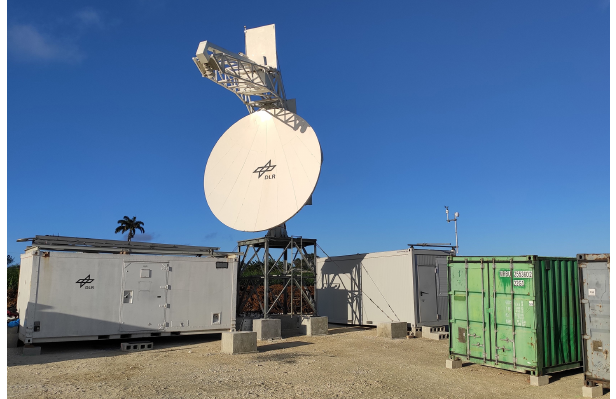
Figure 2. C-band radar Poldirad on Barbados (photo by F. Ewald).